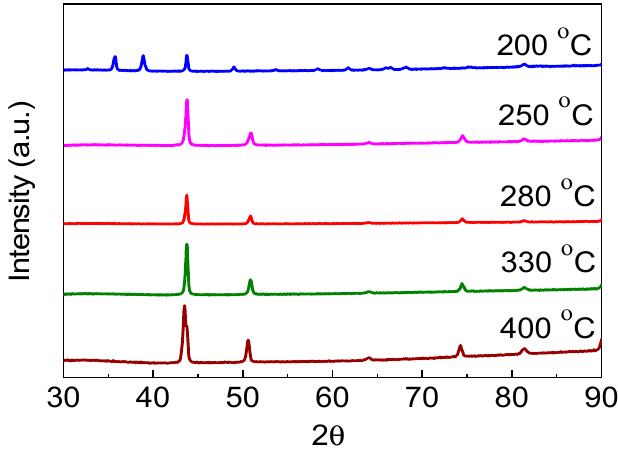
Figure A4. XRD patterns of crushed hollow fibers calcined at 600 °C for different times, followed by reduction at variable temperature for a period of 1 h. The heating rate was set at 10 K/min. All diffraction lines can be assigned to metallic copper, except for the pattern at 200 °C, showing features of copper oxide. Some fibers were analyzed after electrochemical treatment, which did not lead to any changes in the XRD patterns, suggesting the crystalline copper phase remains metallic.